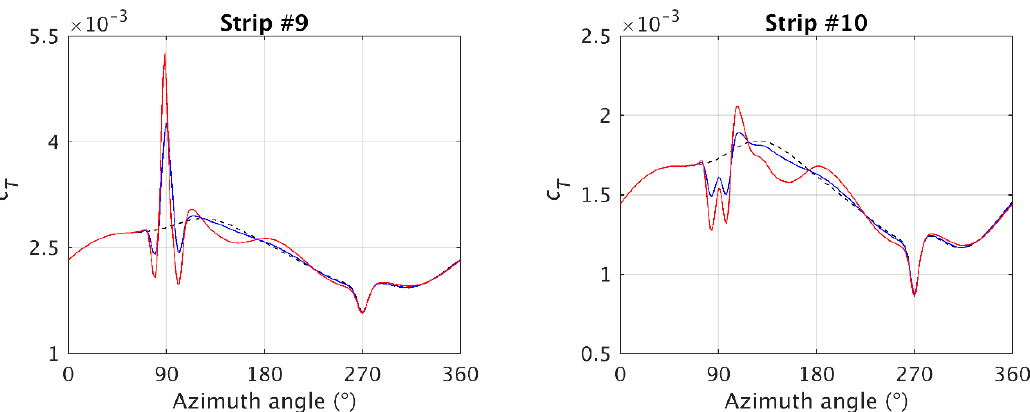
Figure 11. Zero net flow rate gusts: ( top ) total aerodynamic torque over the blade hit by the gust as a function of its azimuth angle and ( bottom ) torque contribution of the four most outboard strips.